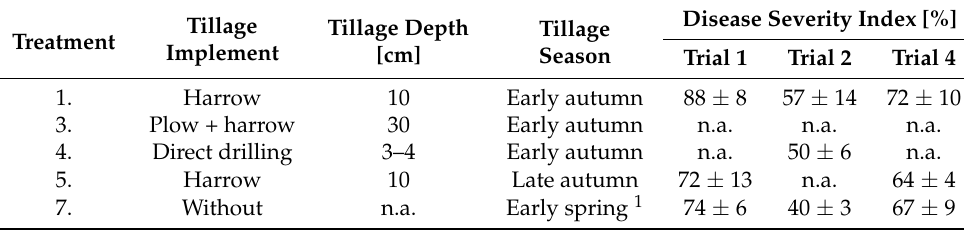
Table 4. Disease severity index of spinach seedlings at the end of the trials ( n = 4; Mean ± SD).